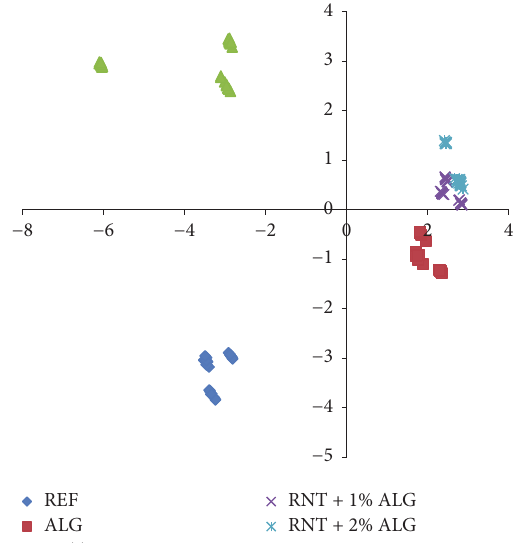
Figure 3: Potentiometric electronic tongue plot showing taste clusters of reference solution (0.0001M Ca(NO 3 ) 2 , 0.0001 M NaCl) (REF), pure ranitidine hydrochloride (RNT), microspheres placebo (ALG), and microspheres prepared with using 1% and 2% ALG solution (RNT + ALG 1% and RNT + ALG 2%, resp.). Samples were placed in 100 mL of deionized water; measurement time was 7 min with signal acquisition every 5 s. The data were processed using Principal Component Analysis (PCA) with autoscaling (author’s original unpublished